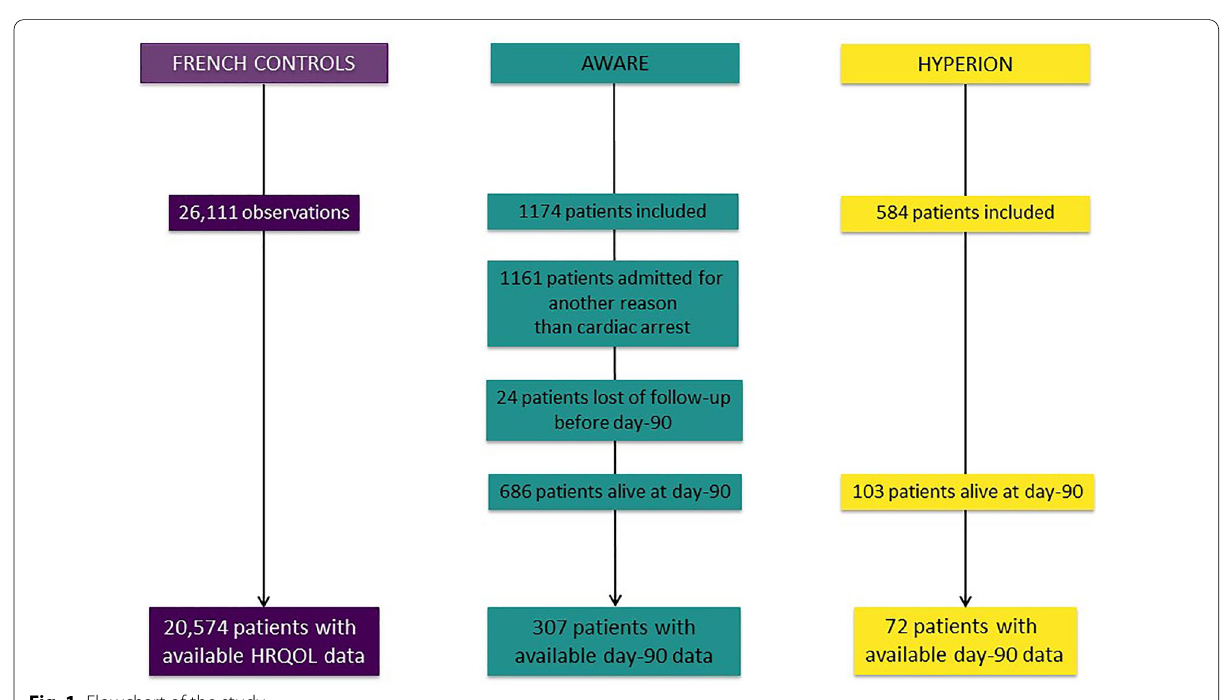
Fig. 1 Flowchart of the study